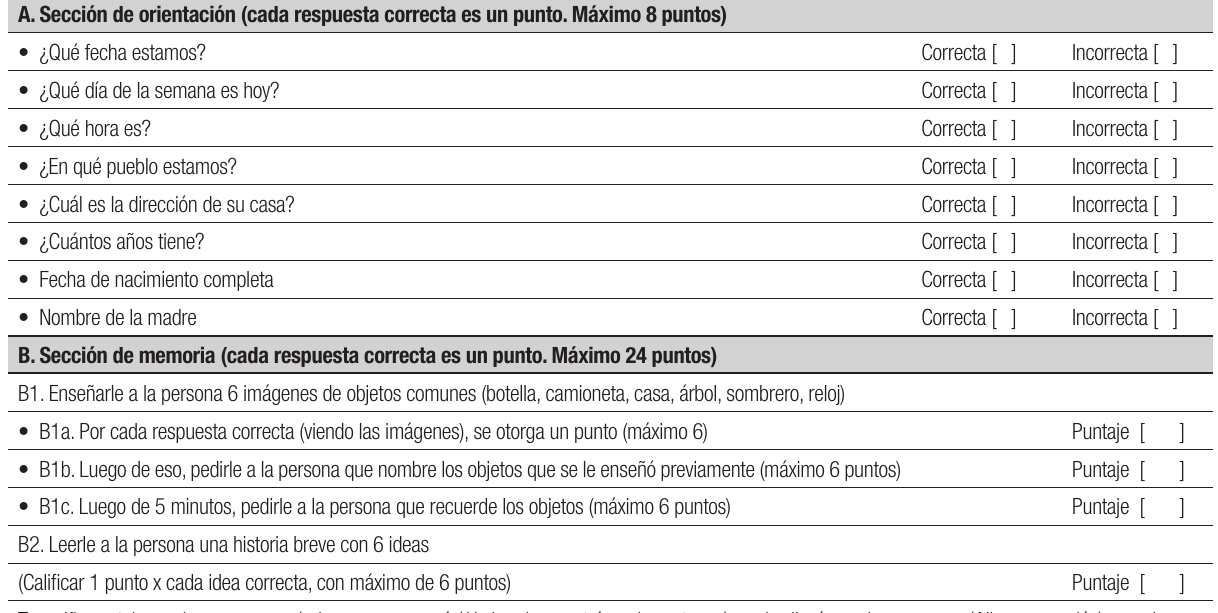
Table 1. Leganés Cognitive Test (original Spanish version).